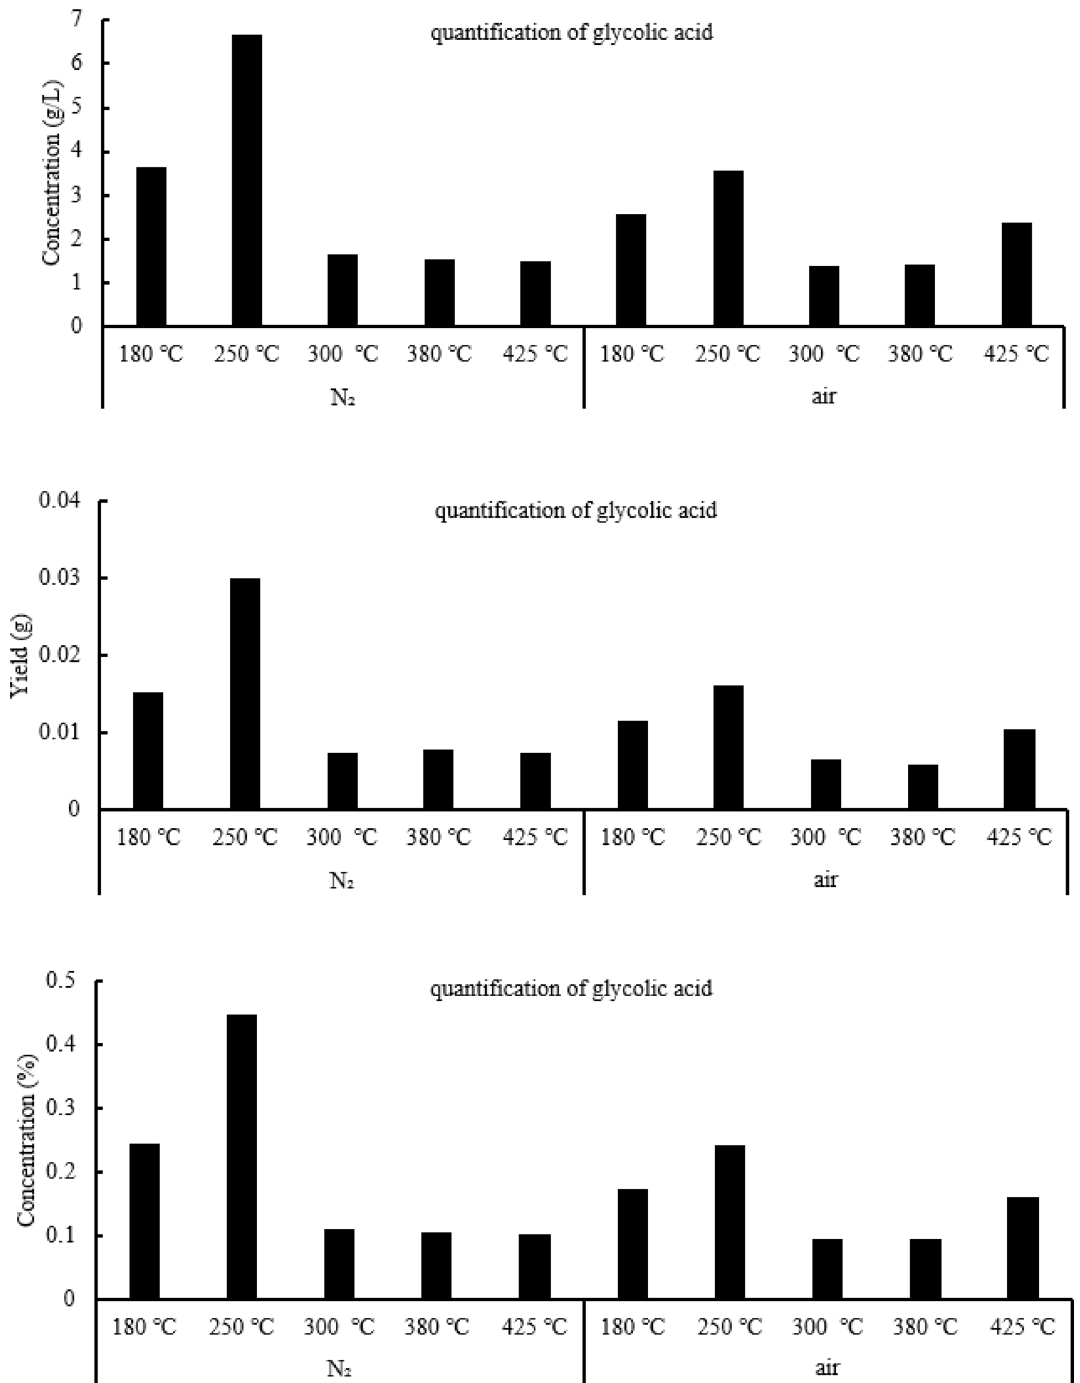
Fig. 9 Quantification of glycolic acid by measured concentration (top; SD < 0.0261) and by yield (bottom; SD <